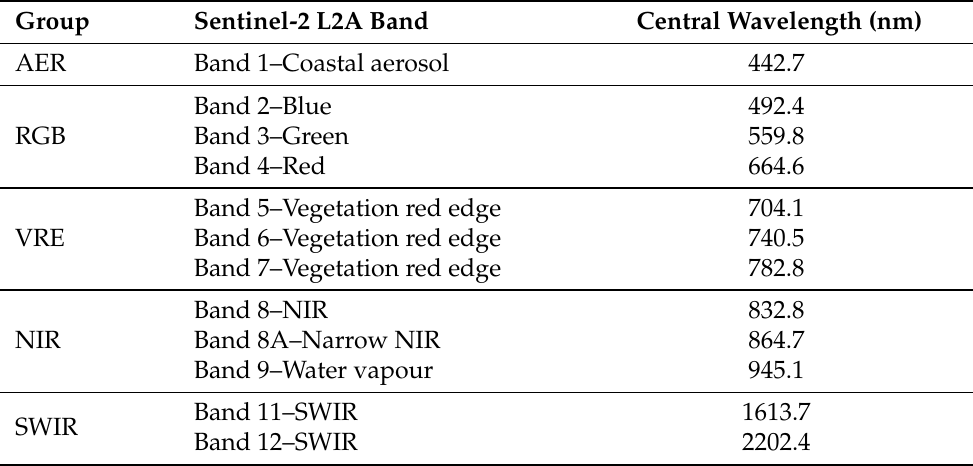
Table 3. Band aggregations following the common responses to terrain bodies.